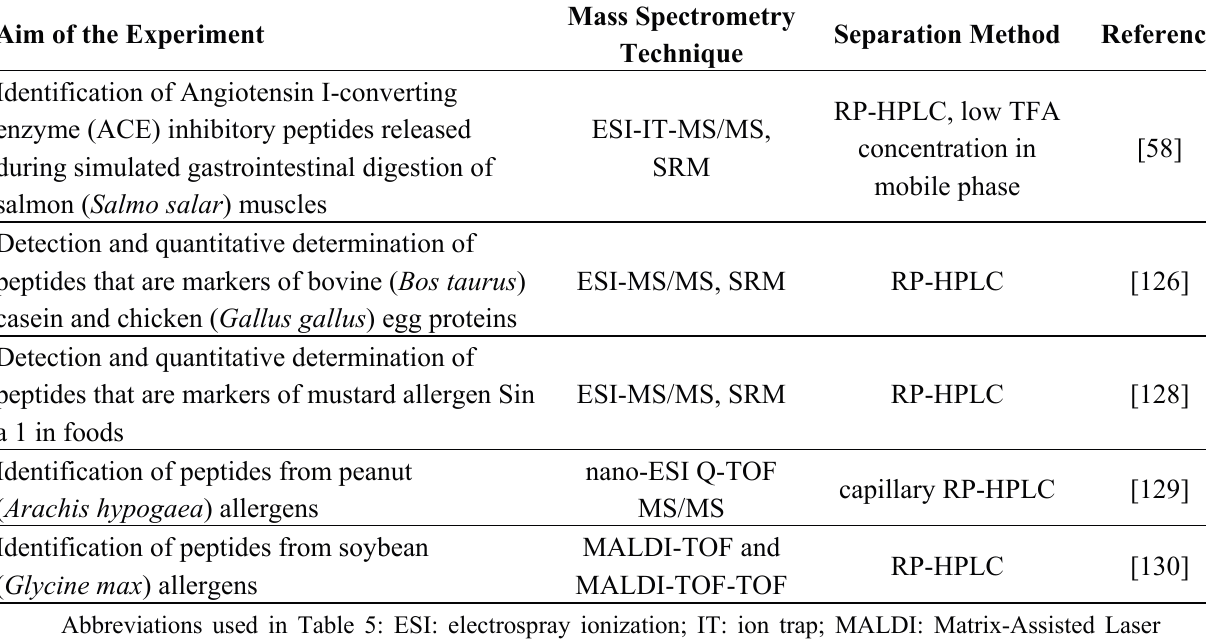
Table 5. Selected applications of mass spectrometry for the identification of food peptides. Aim of the